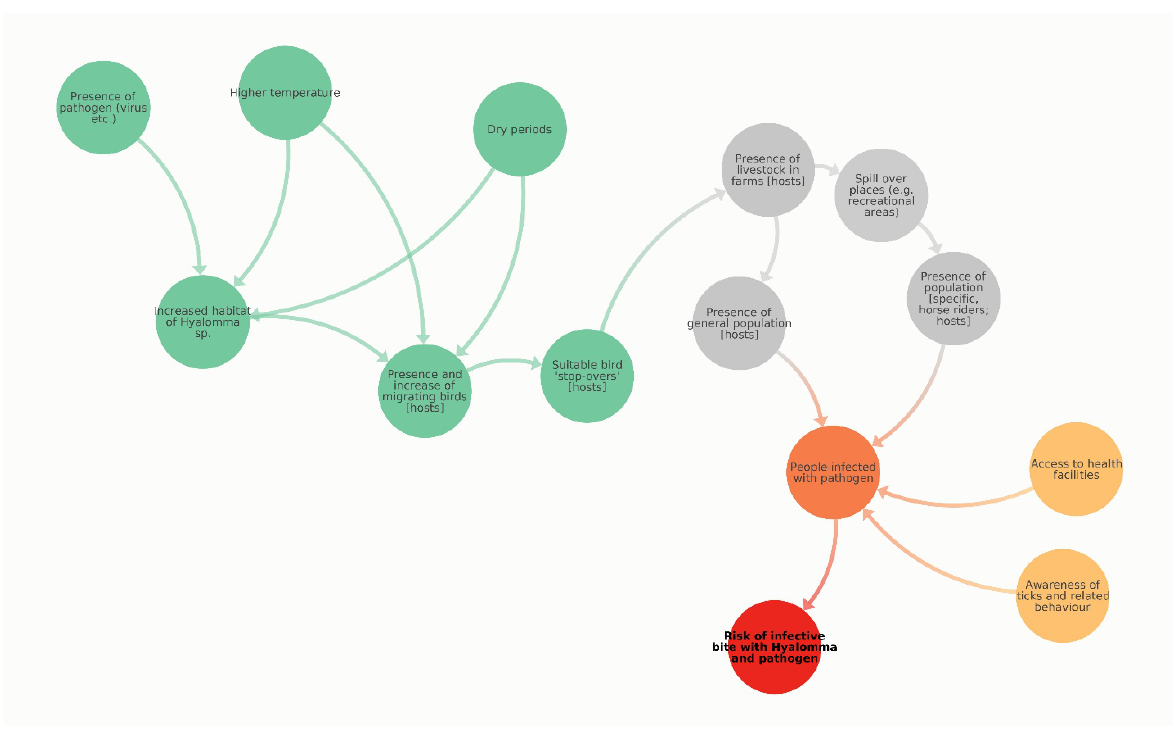
9 of 14 Figure 7. Large livestock animals (horses and cattle) per km 2 . (shapefile source: Verwaltungsgren- zen (VGD) ©BEV, 2021. Regional statictical grid, Statistics Austria. Data.statistik.gv.at, accessed on